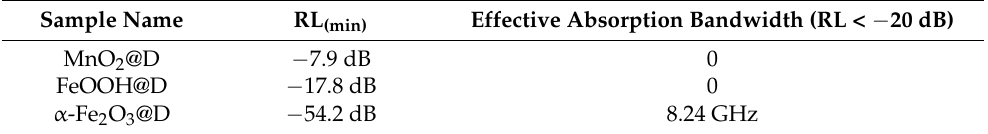
Figure 4. One—dimensional, two—dimensional, and three—dimensional picture of the RL values, Figure 4. One − dimensional, two − dimensional, and three − dimensional picture of the RL values, which varies with frequency and thickness: ( a – c ) MnO 2 @D, ( d – f ) FeOOH@D and ( g – i ) α -Fe 2 O 3 @D. which varies with frequency and thickness: ( a − c ) MnO 2 @D, ( d − f ) FeOOH@D and ( g − i ) α− Fe 2 O 3 @D. Table 1. RL(min) and effective absorption bandwidths (RL < − 20 dB) of MnO2@D, FeOOH@D and α -Fe 2 O 3